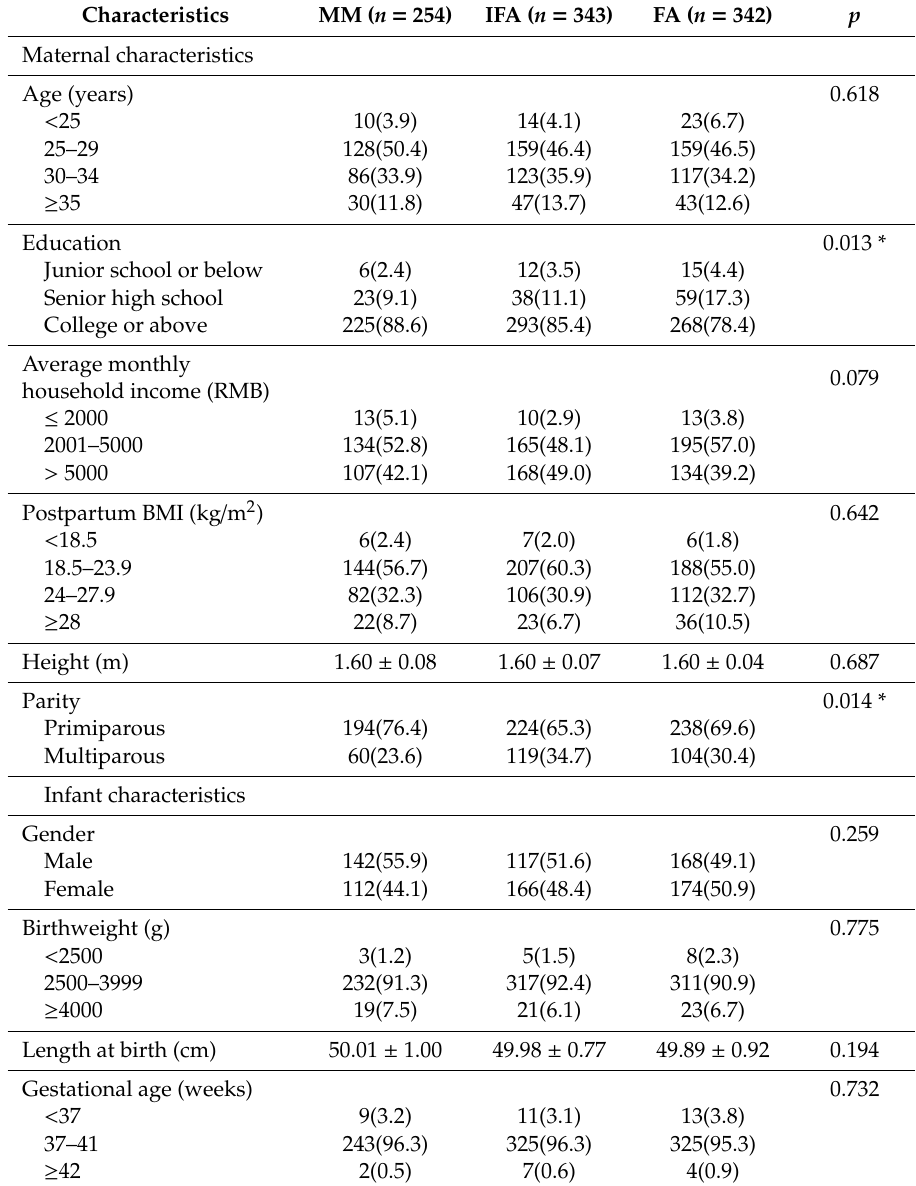
Table 1. Maternal and child characteristics according to prenatal micronutrient supplementation status ( n =